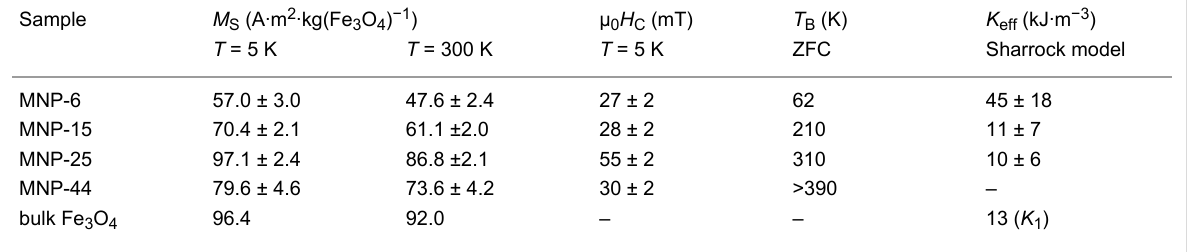
Table 3: Overview of the size-dependent magnetic properties of Fe 3 O 4 –Au NPs. Saturation magnetization M S at 9 T, T = 5 K and T = 300 K, coer- cive field µ 0 H C at T = 5 K, and deduced blocking temperature, T B, and effective magnetic anisotropy, K eff . The bulk Fe 3 O 4 reference values are listed for comparison and referenced in the